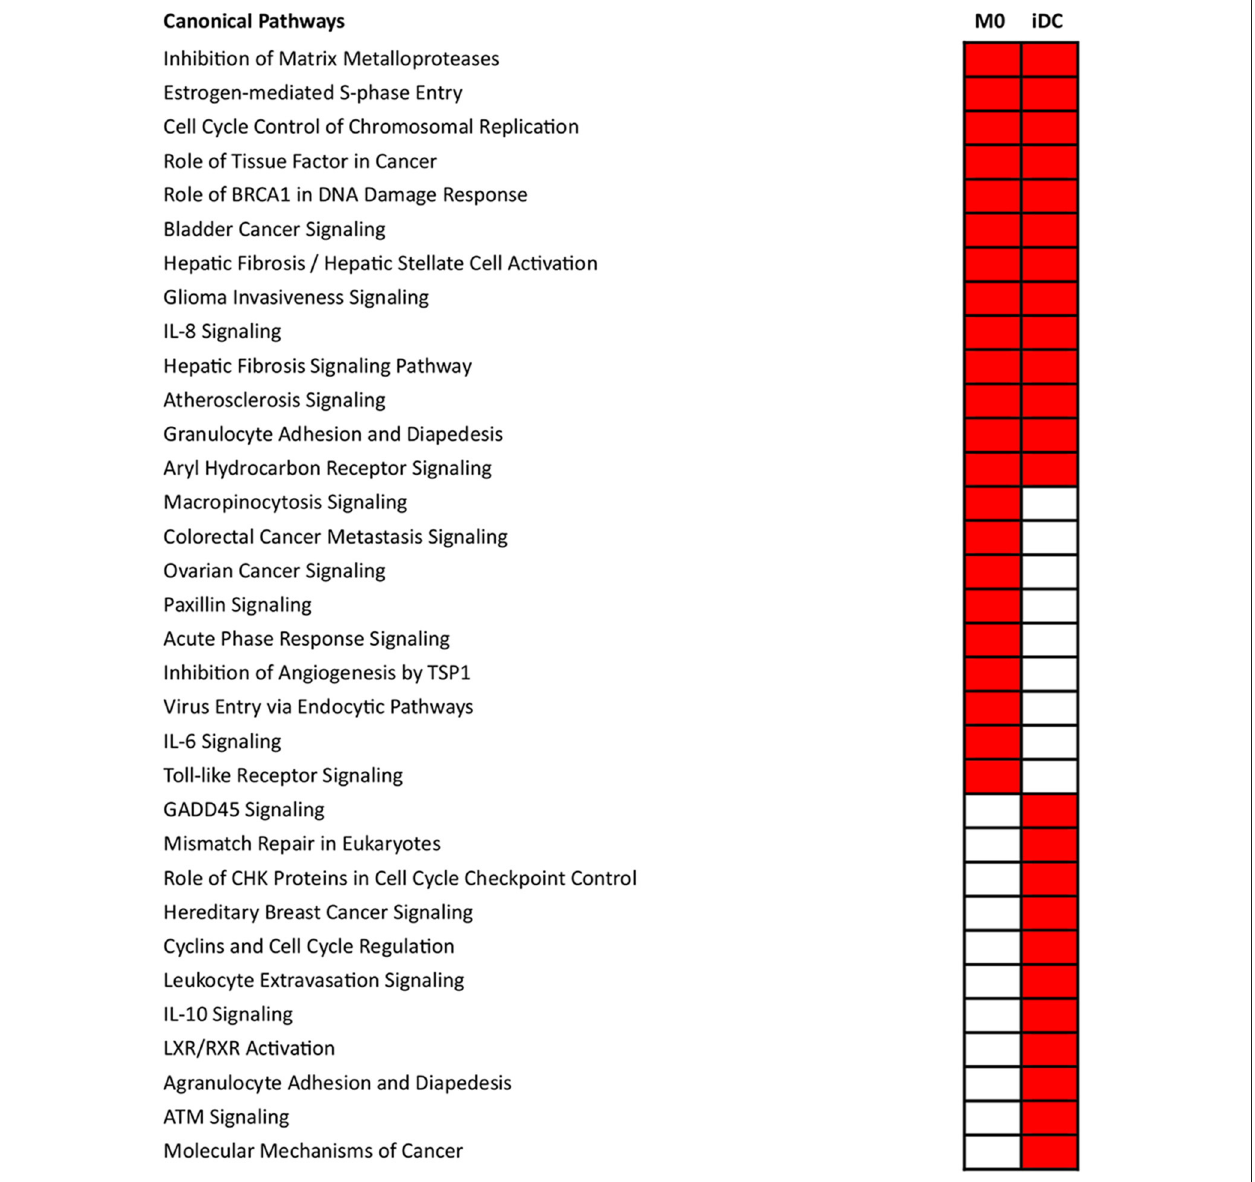
FIGURE 3 | Significantly associated canonical pathways in THP-1 derived macrophage- (M0) and dendritic-like cells (iDC) differed from each other. THP-1 monocytes were non-treated or differentiated into M0 or iDC. Microarray analysis provided data on the transcriptome which was expressed as average fold change between differentiated cells vs. monocytes of 3 independent experimental replicates. Then, the transcriptomes were imported into IPA for canonical pathway analysis. Canonical pathways with a p < 0.001 were selected, labeled in red and listed separately according to the categories: present in both M0 and iDC, only M0 and only iDC. In each category, the pathways were listed from top to bottom following the p -value difference between M0 and iDC from large to